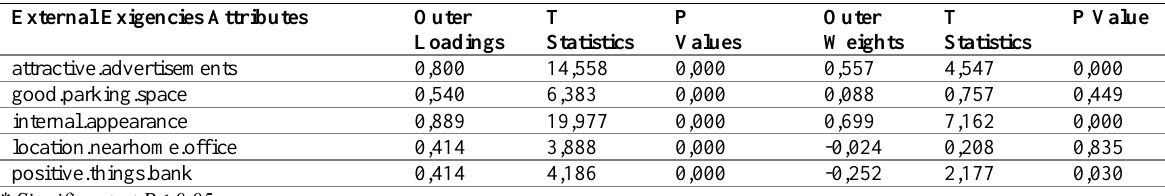
Table 5: Outer loadings and outer weights of External Exigencies